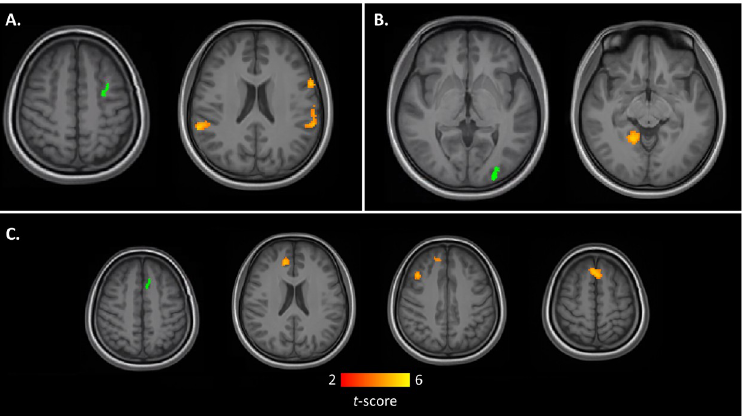
Fig 2. Increased resting state connectivity maps in expert chess players using cortical thickness seeds (in green) from A.) L. Caudal Middle Frontal gyrus, B.) L. V2, and C.) L. Superior Frontal